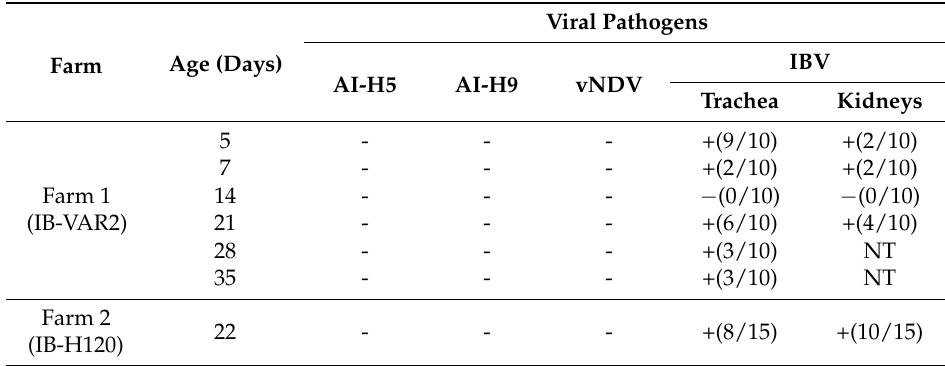
Table 3. Selected viral pathogen real-time RT-PCR detection in farm 1 and